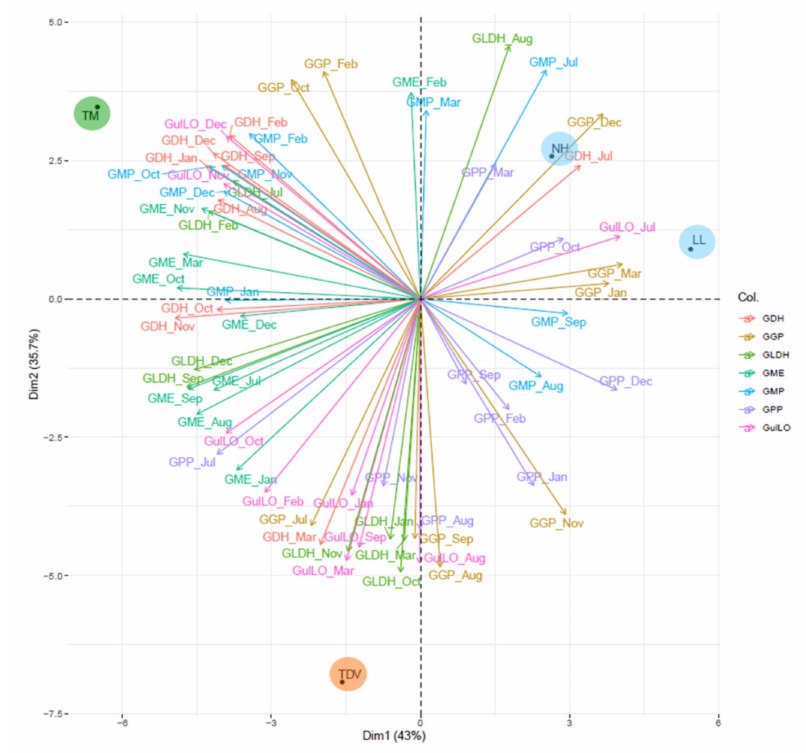
Figure 4. PCA of expression variability of genes involved in the L -galactose and L -gulose pathways evaluated in all sampling events (from July to March). Genes are indicated with different coloured lines. Varieties (Lanelate (LL), Tarocco Meli (TM), Newhall (NH), and Tarocco TDV (TDV)) are indicated in coloured